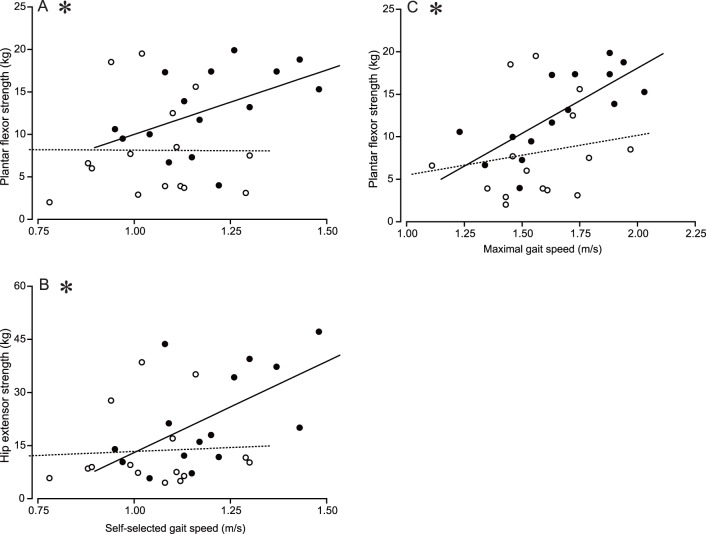
Linear regression of self-selected and maximal gait speed on leg strength before (open symbols, dashed regression lines) and after 16 sessions of leg press training (n = 15).Panel A: before, y = 8.38–0.24x, after, y = 8.84+15.16x; Panel B: before y = 8.89+4.44x, after, y = −35.80+49.91x; Panel C: before, y = 0.84+4.66x, after, y = −12.92+15.50x. The * denotes a significant (p<0.05) difference in the slopes of the regression coefficient before and after training determined by small sample t-test.